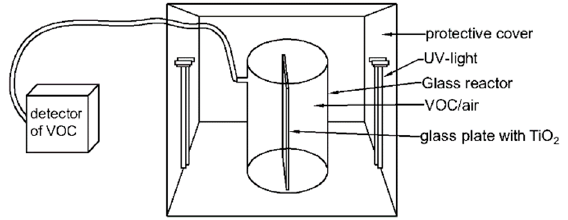
Figure 2. The self-made quartz reactor.